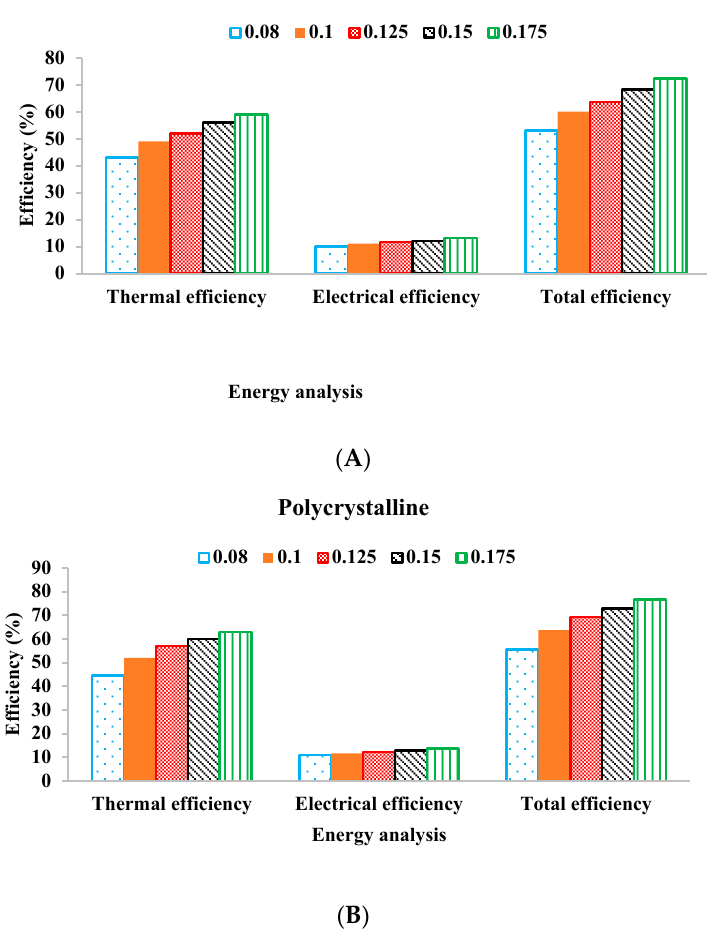
Figure 7. Energy analysis for both monocrystalline ( A ) and polycrystalline ( B ) PV/T systems.